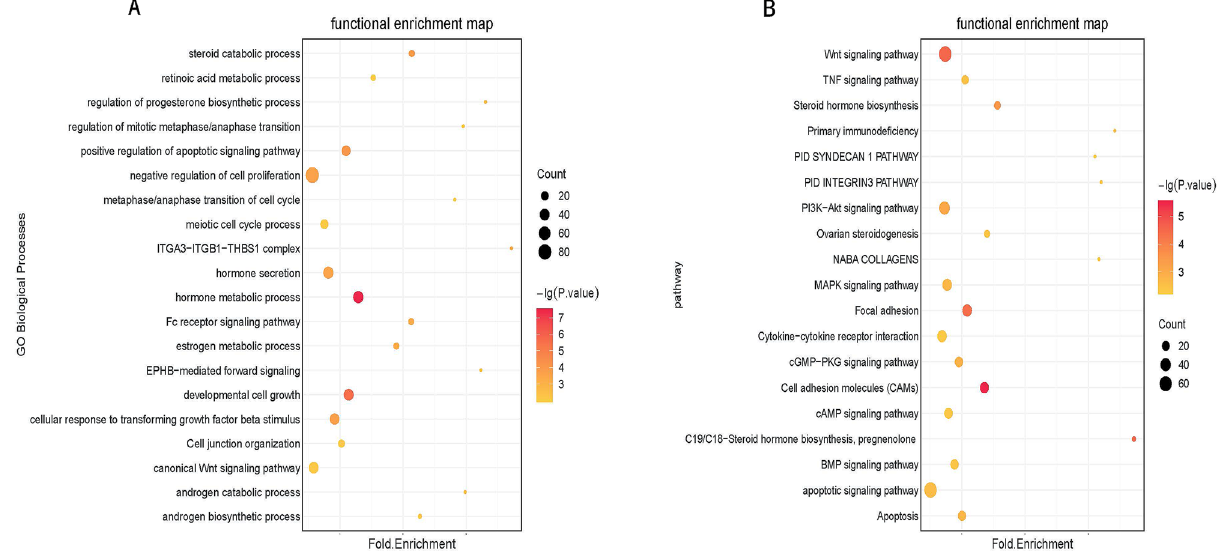
Figure 5. GO and KEGG pathway analysis of the PTGs of differentially expressed lncRNAs